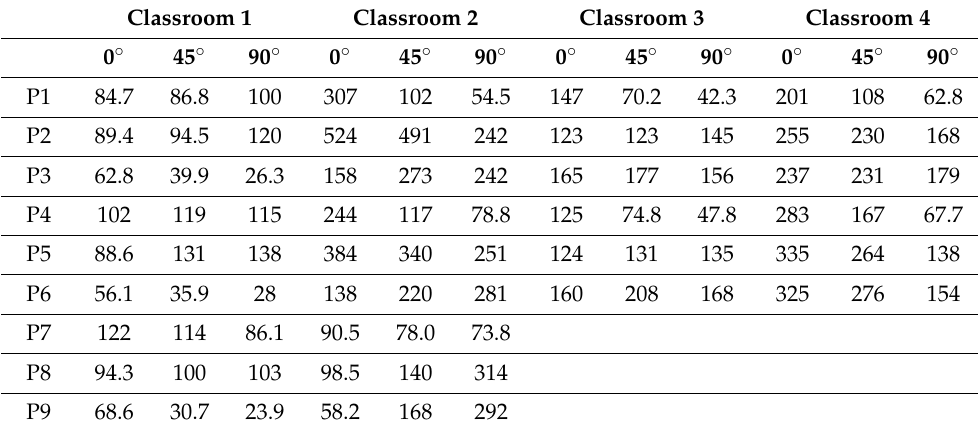
Table 4. Vertical photopic illuminance (lux) simulation the position of the corneal plane (height 1.30 m from the floor). The 0 ◦ orientation is in blackboard direction, 45 ◦ and 90 ◦ from 0 ◦ rotating to the windows location for each classroom.